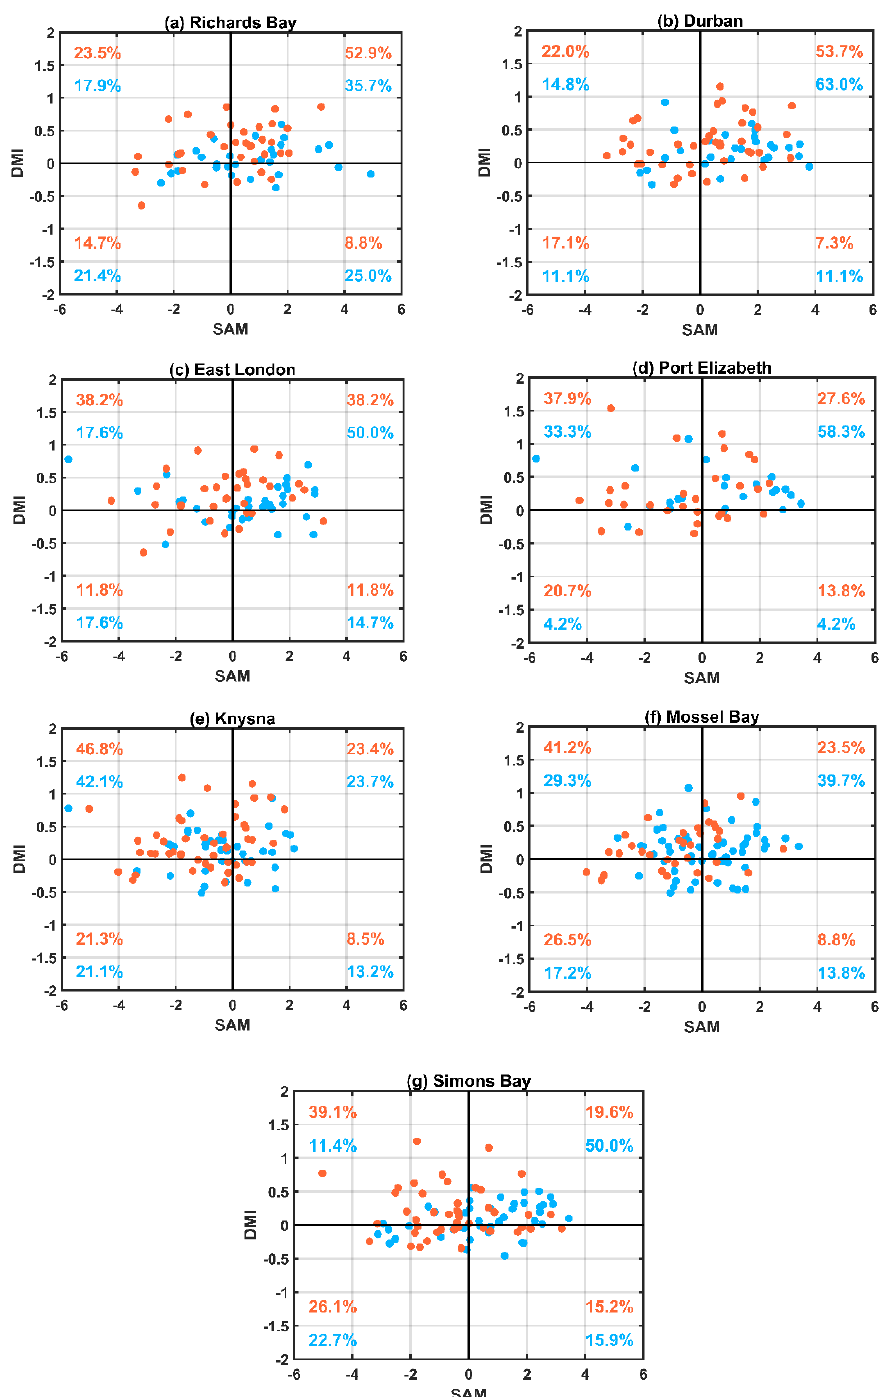
Figure A2. The MEI/SAM combinations in months with higher/lower (in red/blue) sea level than 1.5 standard deviations above/below mean sea level at ( a ) Richards Bay, ( b ) Durban, ( c ) East London, ( d ) Port Elizabeth, ( e ) Knysna, ( f ) Mossel Bay and ( g ) Simons Bay, respectively. The percentages indicate the number of SL months within a quadrant divided by the total number of the recorded SL months of the paired interactions.